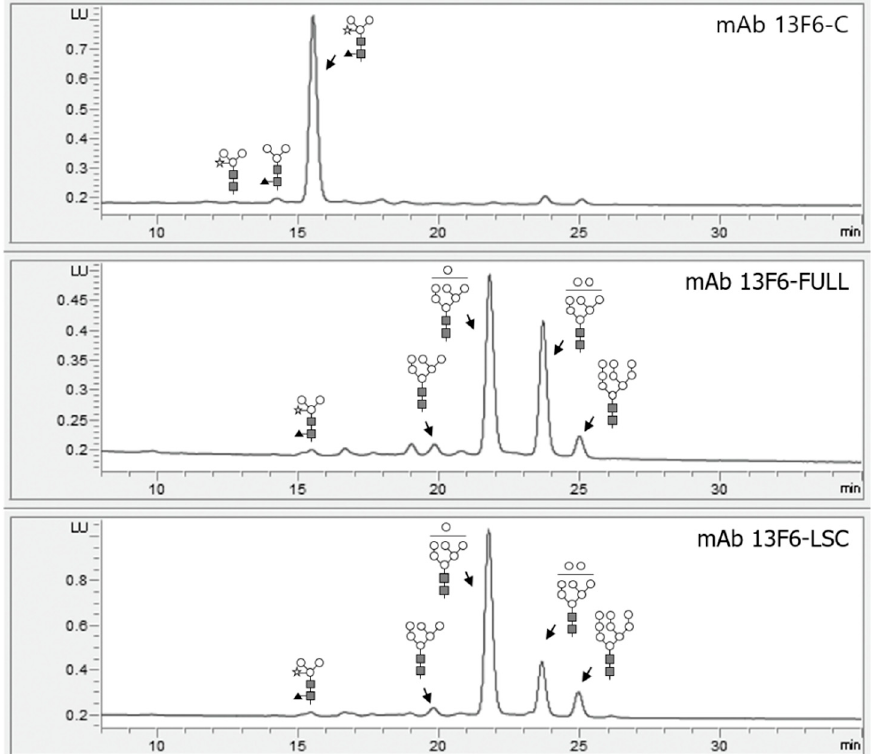
Figure 5. HPLC analysis of the N- glycosylation of mAb 13F6-C, mAb 13F6-FULL and mAb 13F6-LSC. The profiles of the 2-aminobenzamide (2-AB)-labeled N- glycan released from mAb 13F6-C ( top ), mAb 13F6-FULL ( middle ) and mAb 13F6-LSC ( bottom ) were analyzed using HPLC. The proposed N- glycan structures for each peak were designated. The symbols of the glycan structures are as follows: N- acetylglucosamine, gray square; mannose, white circle; xylose, white star; fucose, black triangle.